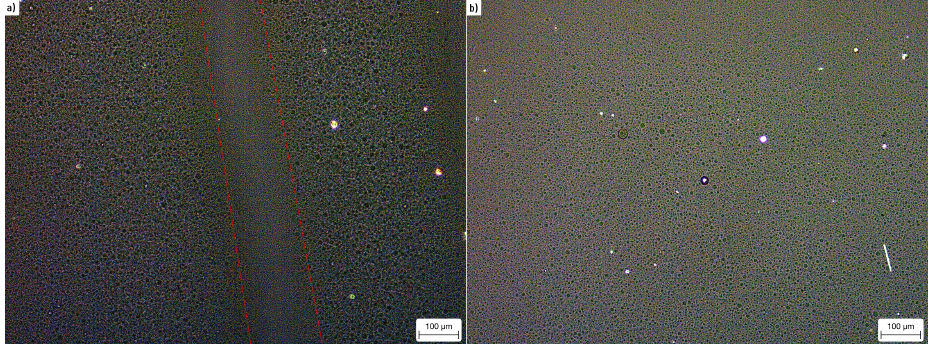
Figure 6. Polarised light micrograph of ( a ) Emulinit 8L; ( b ) Bulk EE matrix. The diagonal red lines indicate the region, in which sensitizing is on-going.